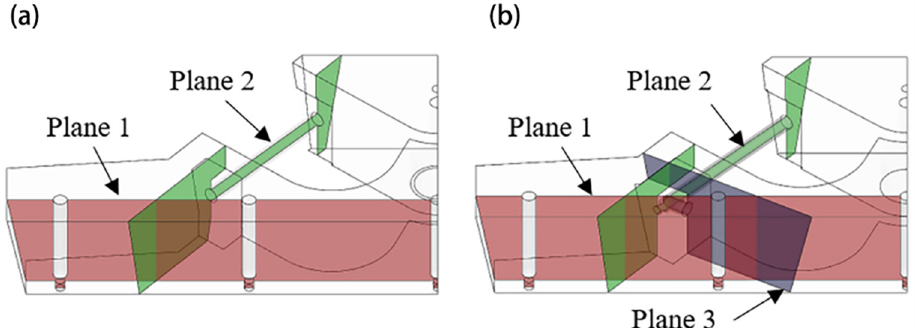
Figure 3. Schematics of the sections for numerical analysis: ( a ) Case S0; ( b ) Case FK-A0. Table 2. Plan chart for numerical analysis.